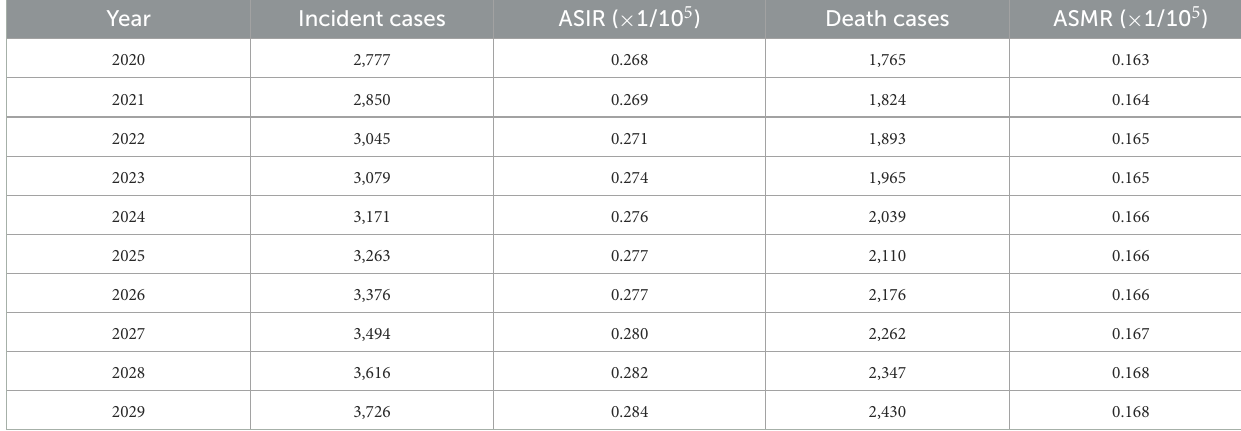
TABLE 5 Incidence and death of ovarian cancer attributable to hyperglycemia in China predicted by neuro-network model from 2020 to 2029. Year Incident cases ASIR ( × 1/10 5 ) Death